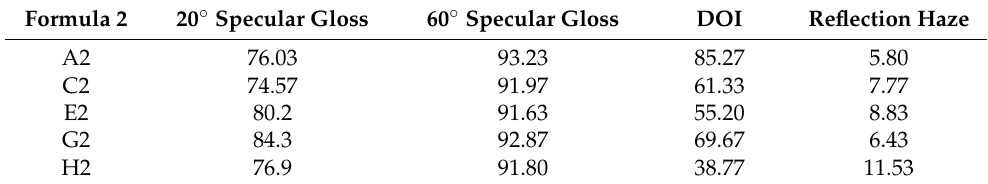
Table 14. The coating surface quality results of coatings prepared by Formula 2. Formula 2